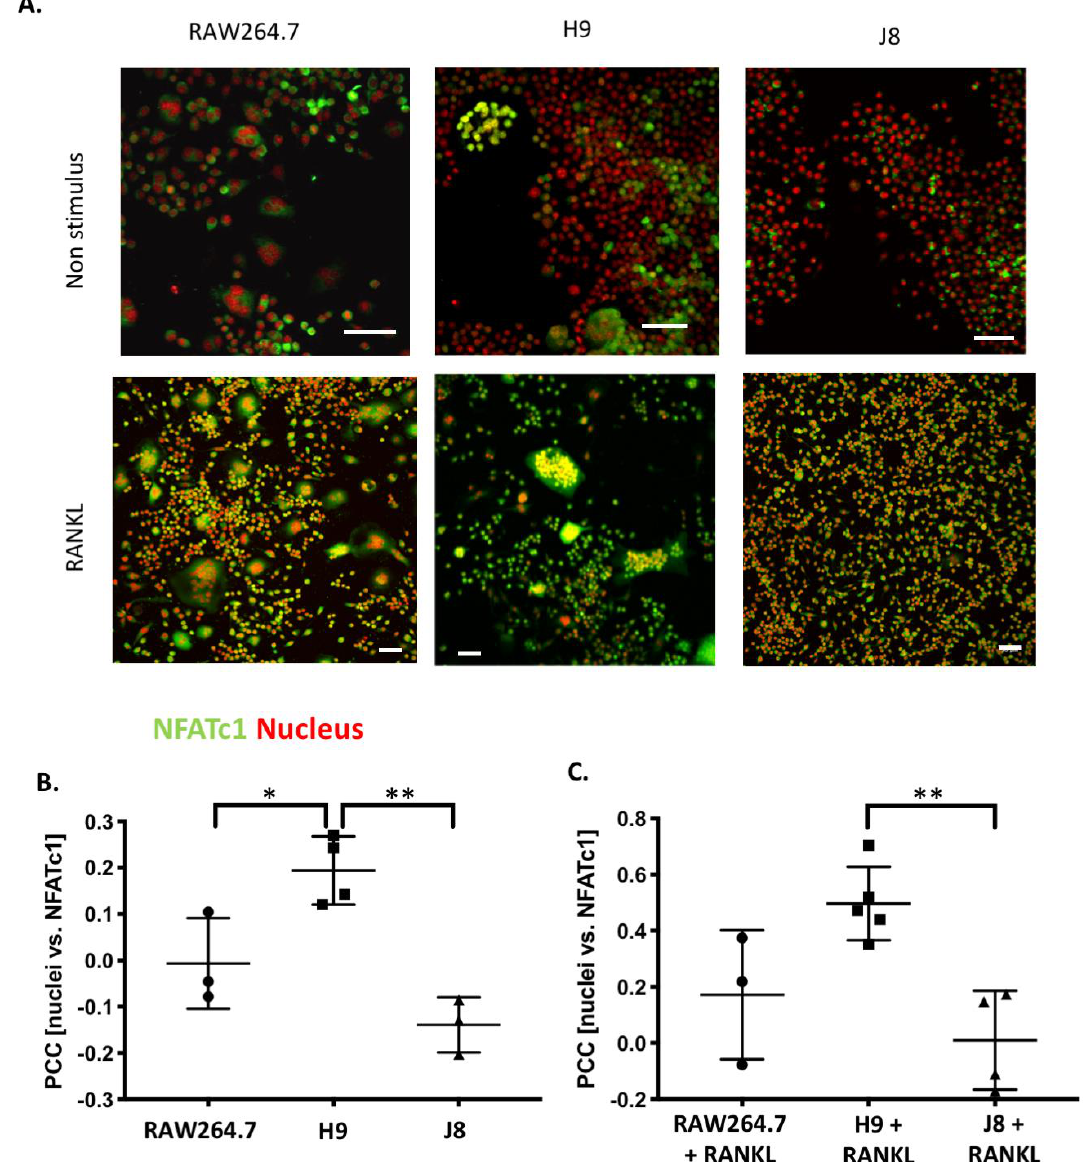
Figure 6. Nuclear translocation of NFATc1 in unstimulated and RANKL-stimulated RAW264.7, H9 and J8. ( A ) RAW264.7, H9 and J8 were stained for NFATc1 (Anti-NFAT2 antibody [7A6] (green) and nuclei with Hoechst 33342 (red)). Active NFATc1 translocated to the nucleus is represented by the yellow color. Scale bar 50 μm. ( B ) Pearson correlation of NFATc1 and cell nucleus in unstimulated cultures and ( C ) in cultures with 10 ng/mL RANKL. Quantification was done using ImageJ (mean ± SD, n = 3), statistical analysis with multiple comparison ANOVA followed by Turkey´s multiple comparison test * p < 0.05, ** p < 0.01 , n = 3.